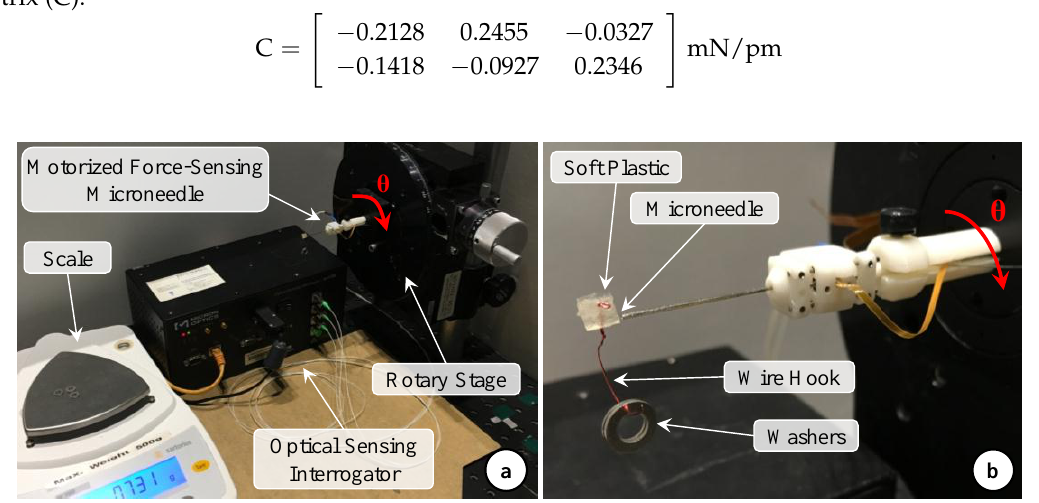
Figure 4. ( a ) Setup for calibration experiments: The force-sensing micro-needle was held horizontal and mounted on a rotary stage to modulate its axial orientation (θ); ( b ) The microneedle tip was inserted into a soft plastic piece carrying a wire hook. Forces were applied at the needle tip by hanging washers of known weight on the hook.